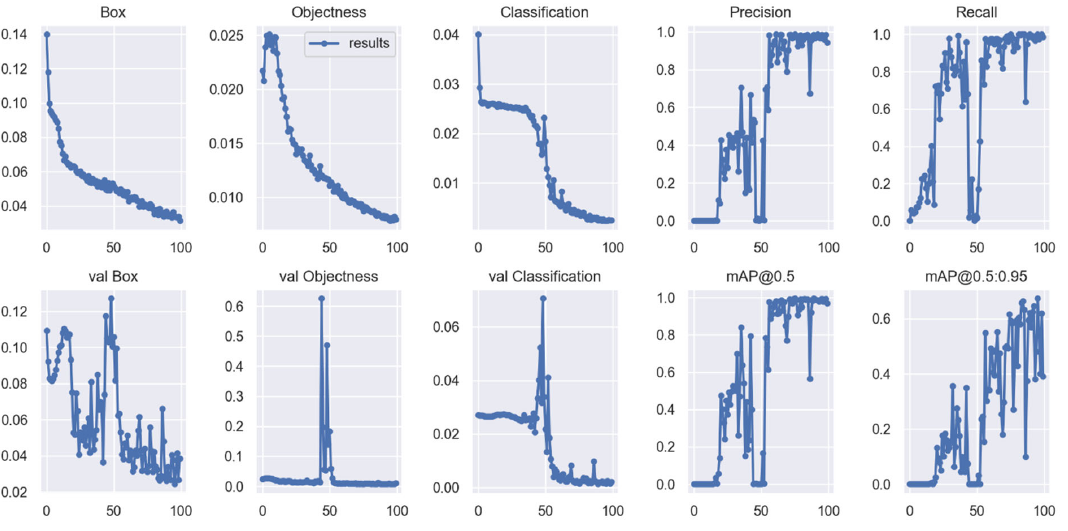
Figure 6 . Visualization of various metrics (e.g., precision, recall, mAP 0.5 , etc.) with the number of epochs (i.e., x ‐ axis) during training and validation .